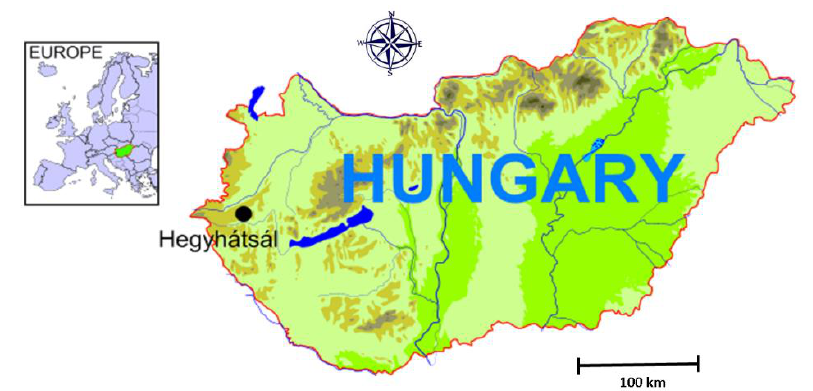
Figure 3. Location of the monitoring site at Hegyhátsál.